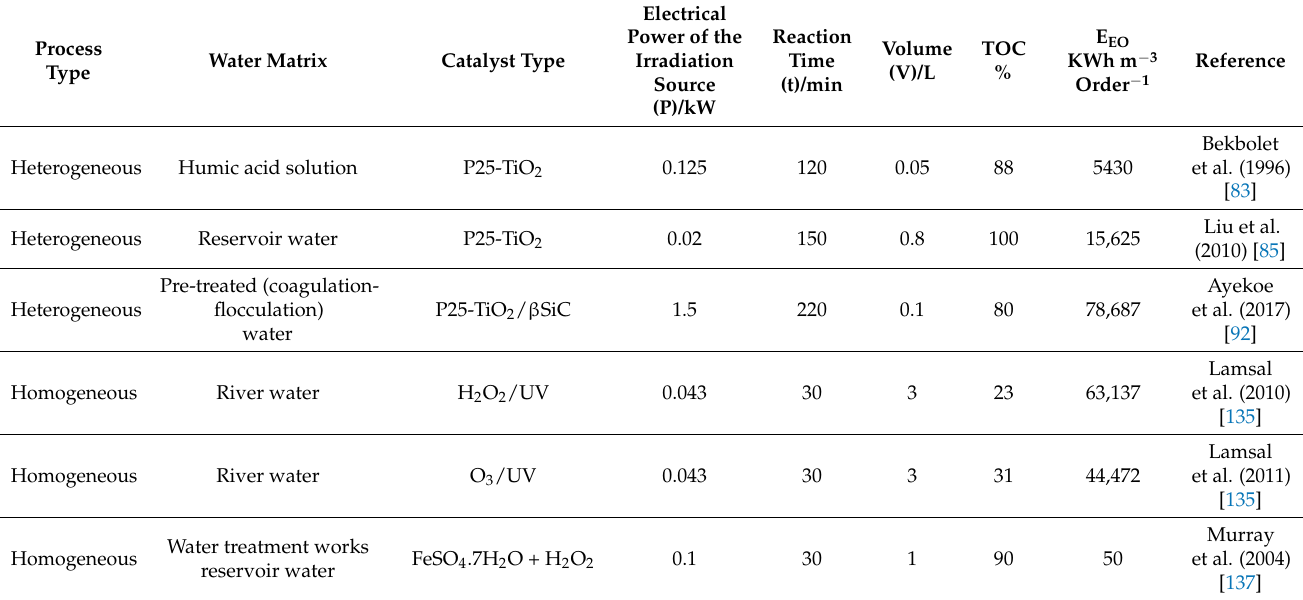
Table 4. Energy efficiency comparison of photocatalytic treatments of